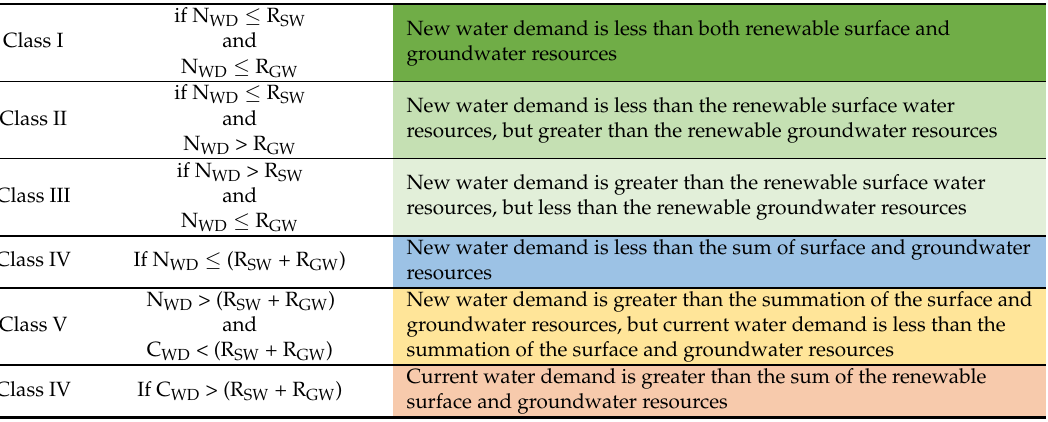
Table 4. Classification of countries based on renewable water resources and increased irrigation water demand.